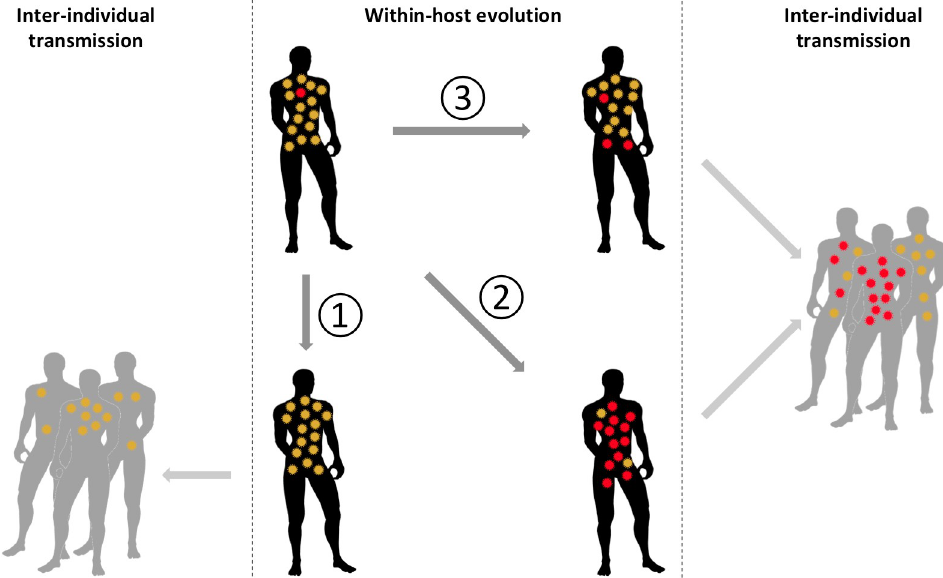
Fig 1. The 3 scenarios following variant apparition within one infected individual. Red: newly formed variant; yellow: progenitors.